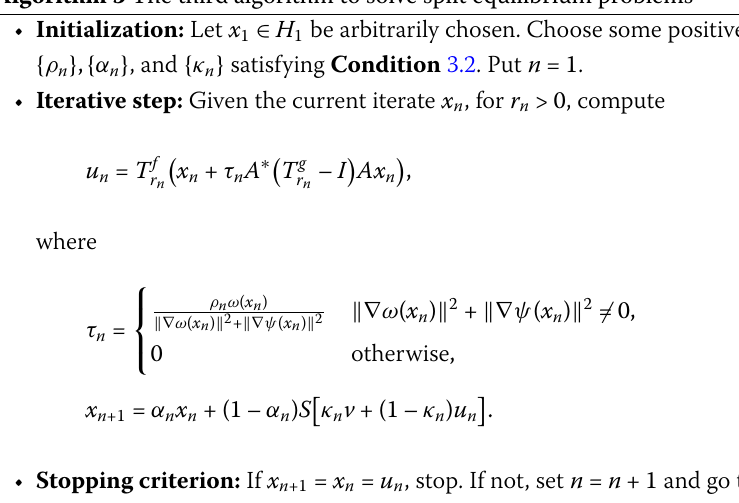
Algorithm 3 The third algorithm to solve split equilibrium